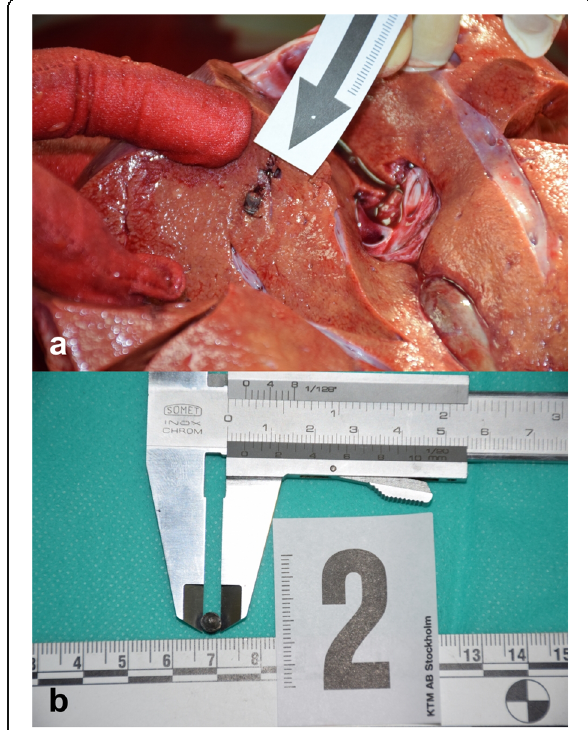
Fig. 5 The 4.5-mm pellet found in the right lobe of the liver ( a ) and removed during the autopsy ( b